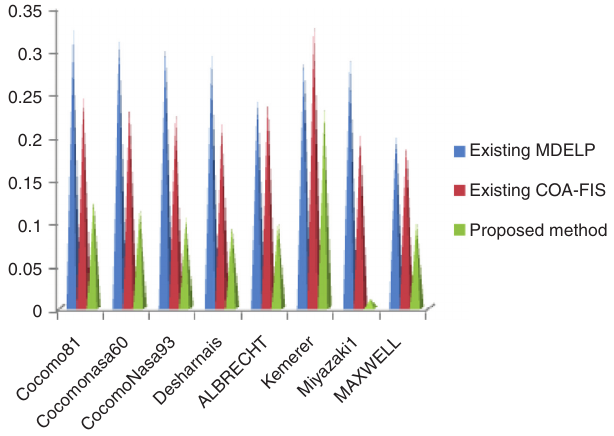
Figure 3: MMRE Comparison between the Existing and Proposed Method.